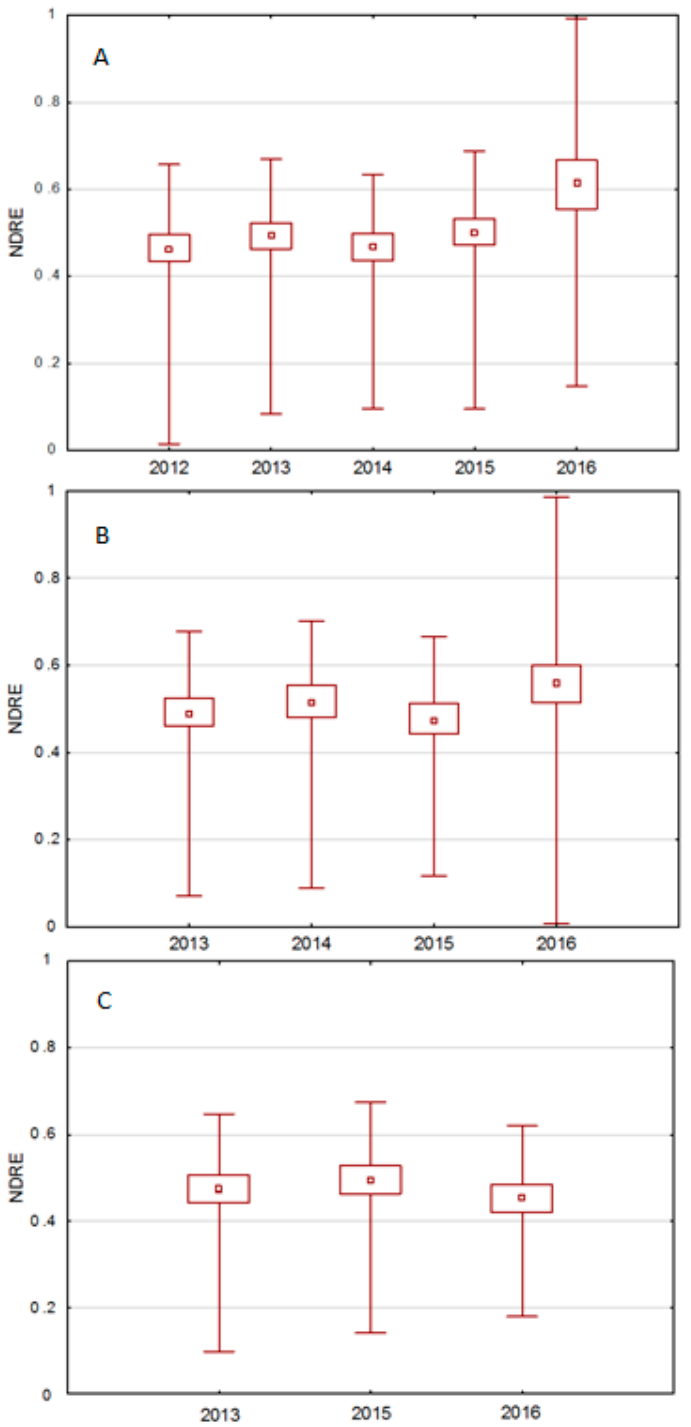
Figure 6. Box and whisker plot of the NDRE vegetation index for area A, B and C. The first and third quartiles define the box; the median is shown as “ □ ”; and the whisker defines the range of the data.